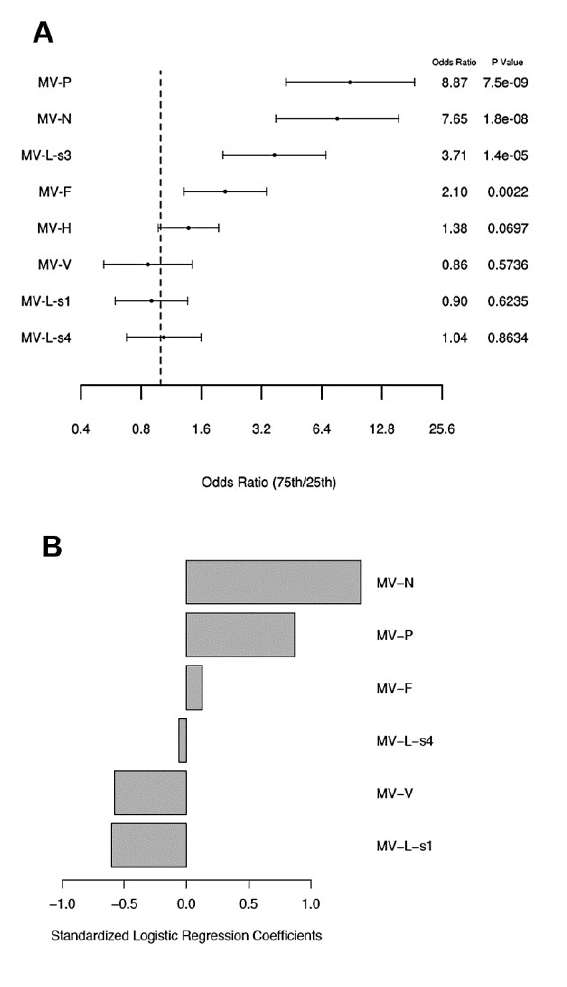
Figure 3. Logistic regression model results for measles neutralizing antibody response. ( A ) Univariable logistic regression model results for neutralizing antibody response for each protein antibody measurement. Forest plot displaying the odds ratios and the corresponding confidence intervals and p -values, for the variables (proteome microarray measurements) as predictors for high relative to low neutralizing antibody response from logistic regression models. Odds ratios represent the odds of a subject having a high neutralizing antibody response relative to low when the corresponding protein microarray reactivity measurement changes from the 25th percentile to the 75th percentile. The vertical dashed line corresponds to an odds ratio of 1.0. ( B ) Multivariable logistic penalized regression model results for neutralizing antibody for all protein measurements. Results from the elastic net logistic regression models for the association of the microarray antibody reactivities (to MV proteins) with neutralizing antibody response. The standardized logistic regression coefficients (1.4 for anti-N microarray reactivity, 0.87 for anti-P microarray reactivity, 0.13 for anti-F microarray, −0.58 for anti-V microarray reactivity, −0.6 for anti-L-s1 microarray reactivity, and −0.06 for anti-L-s4 microarray reactivity) presented are for the microarray measurements that were selected from the model with the validated minimum misclassification error rate (misclassification error = 0.13, C-statistic =